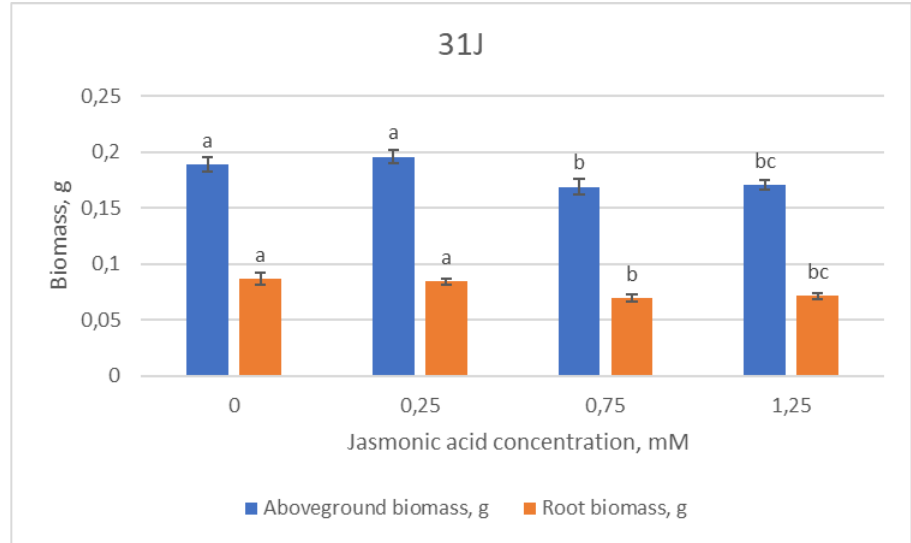
Figure 5. Means (g) ± SE of above-ground and root biomass of Scots pine half-sib family 31J, measured 6 weeks after sowing. Data significance was calculated using the Kruskal–Wallis H test for ranks and post hoc Dunn’s test for pairs ( p < 0.05). Different letters next to different colors indicate significant differences between the groups, sprayed with different concentrations of jasmonic acid.